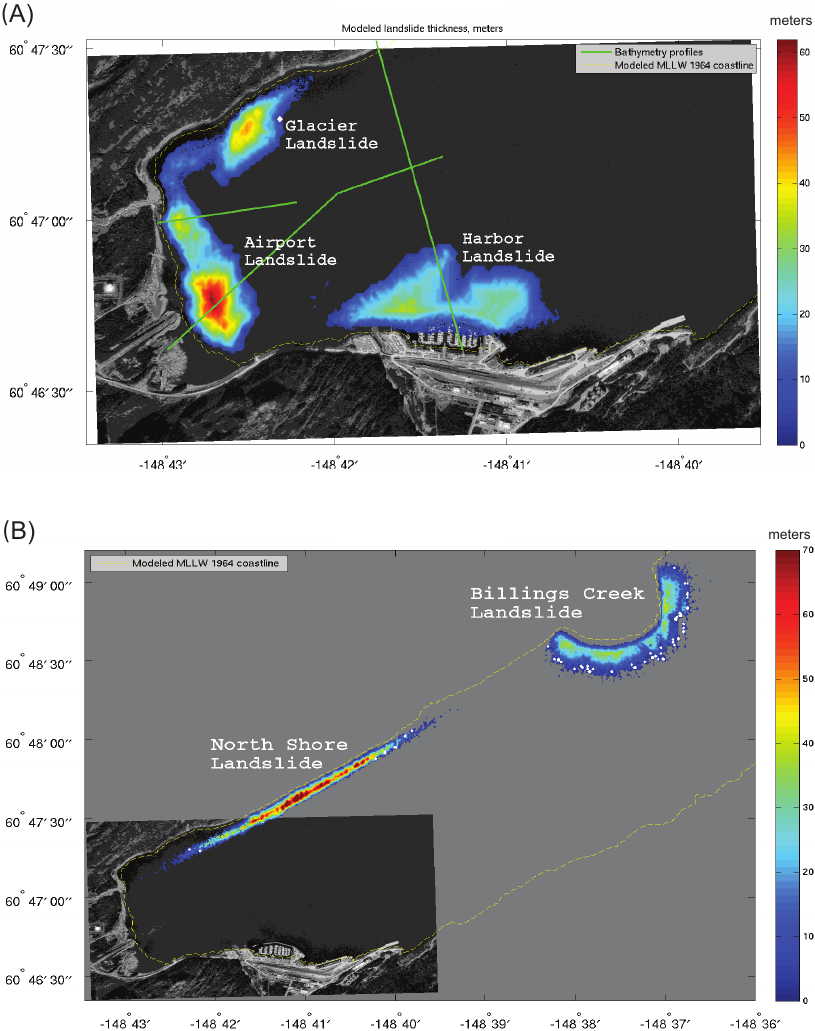
Fig. 5. The initial thickness of landslides. The upper plot shows the Harbor-Airport-Glacier (HAG) landslide complex , 1 . 5 × 10 7 m 3 in volume. The bottom plot shows locations and thicknesses of the North shore and Billings Creek landslides. Each landslide is 1 . 0 × 10 7 m 3 . The location of bathymetry profiles used to constrain the HAG landslide are shown by green lines. The modeled MLLW shoreline before the earthquake is shown by a dashed yellow